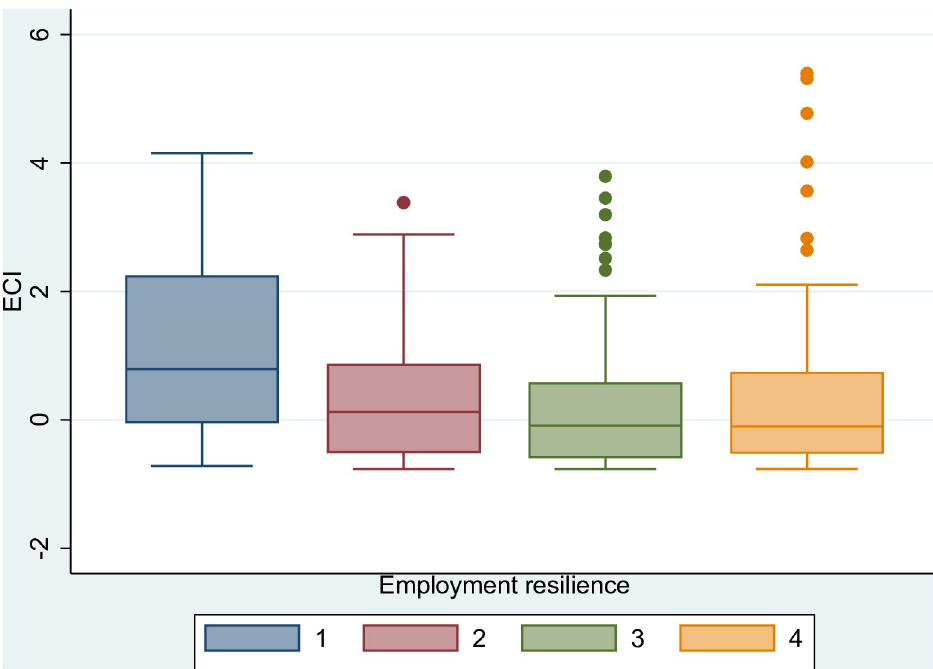
Fig 13. Employment resilience and ECI. Employment resilience measured using the index developed by ESPON [69]: 1 = resistant to the economic crisis; 2 = recovered from the economic crisis; 3 = not recovered but experienced economic upturn; 4 = not recovered and still experiencing economic downturn. The figure has been generated using StataSE 14.